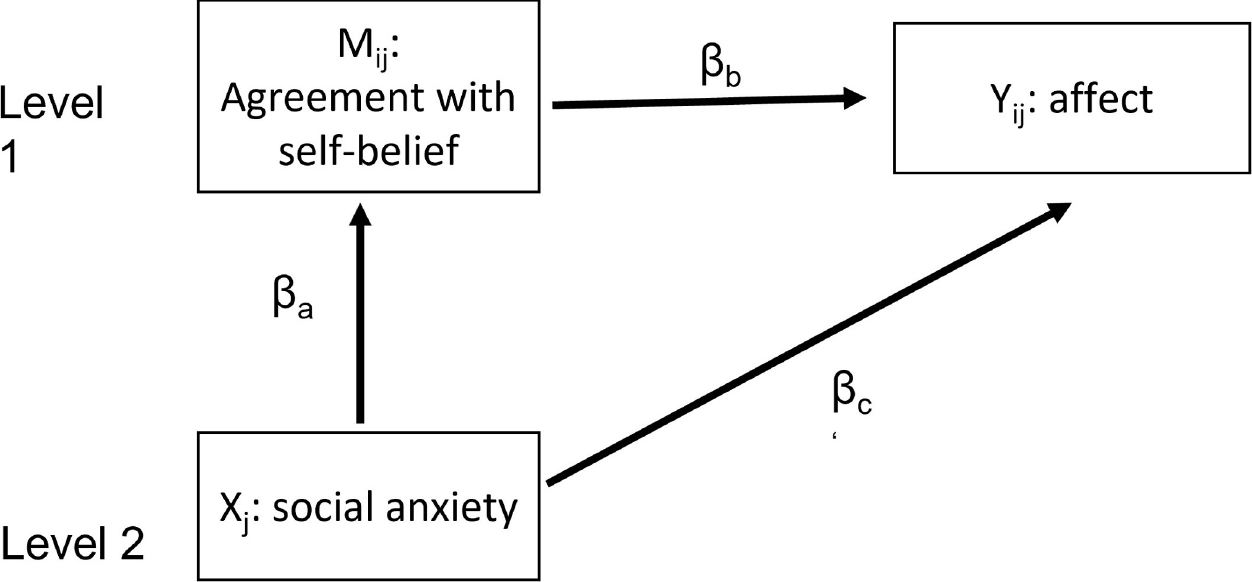
Fig 3. Schematic for the proposed multilevel mediation model. 2-1-1 mediation model, with social anxiety status (HSA vs. LSA) as a level two predictor, agreement with self-beliefs as a level one mediator and affect (either positive or negative) as a level one outcome variable. Mij = mediator, Xj = predictor, Yij = outcome, β c = direct effect, β a β b = mediated or indirect effect of social anxiety status on affective response.